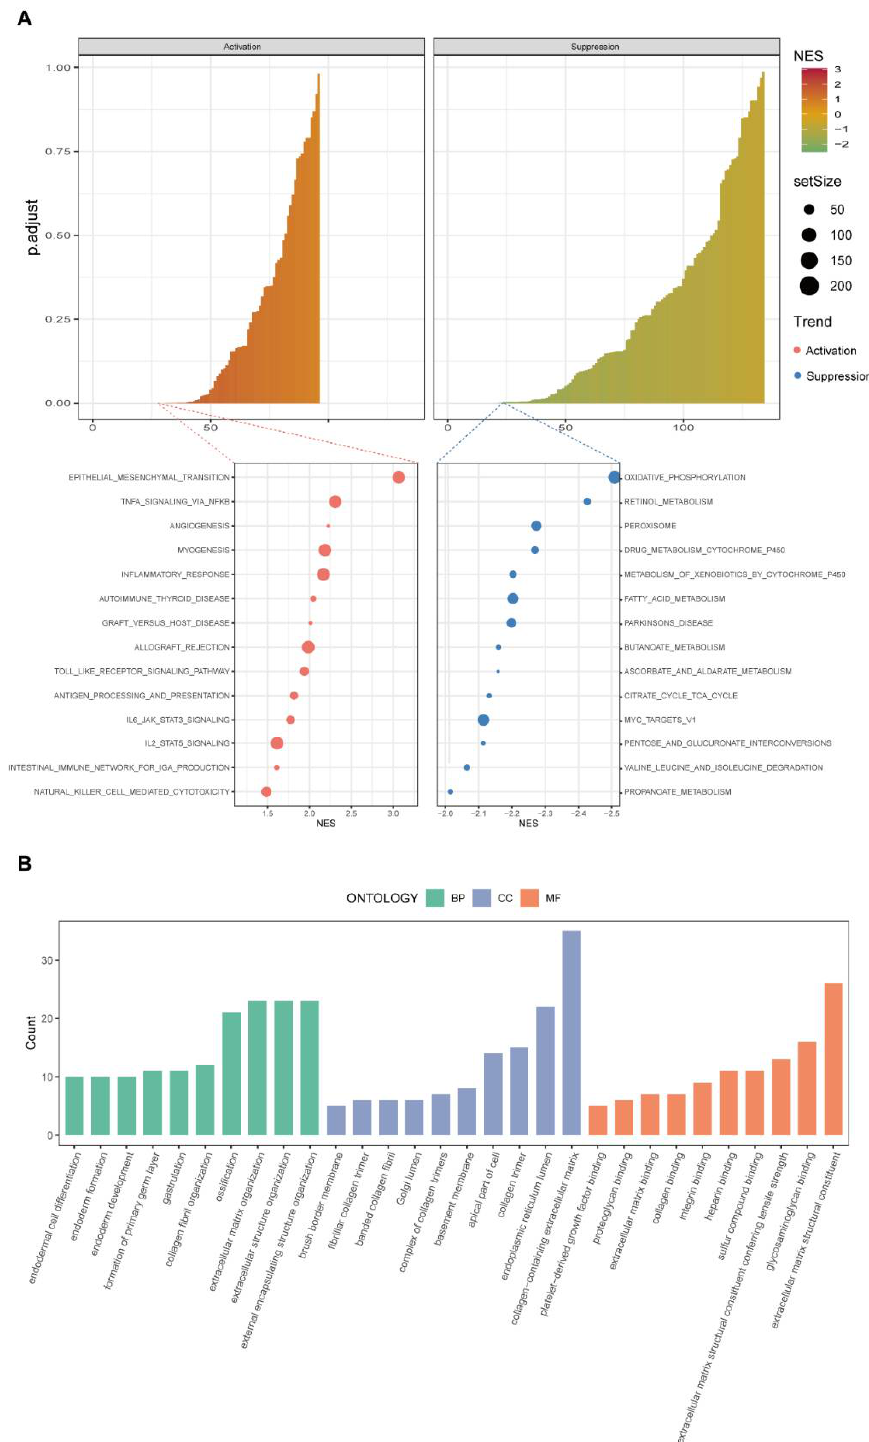
Figure 6. Pathway enrichment and gene ontology analyses of CRC patients based on the necroptosis − related lncRNA prognostic model. ( A ) GSEA revealed the activation of some immune − associated pathways and tumour progression pathways in high − risk CRC patients. ( B ) GO analysis revealed that biological processes (BP, green colour), cellular components (CC, blue colour) and molecular functions (MF, orange colour) were activated in the high − risk group of CRC